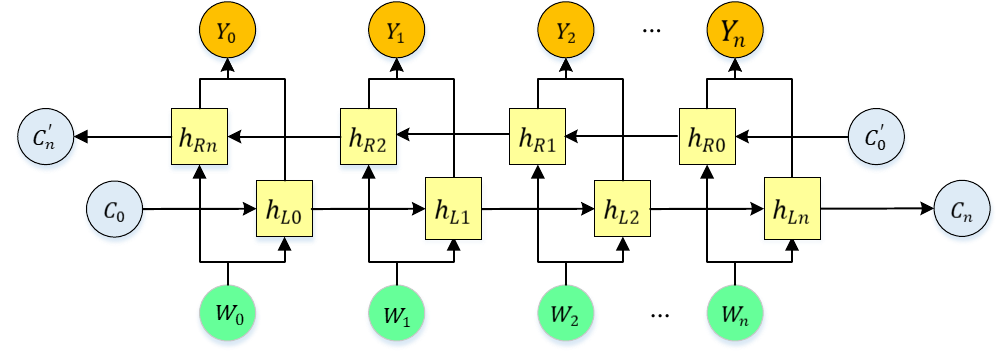
Figure 8. Bi-LSTM model